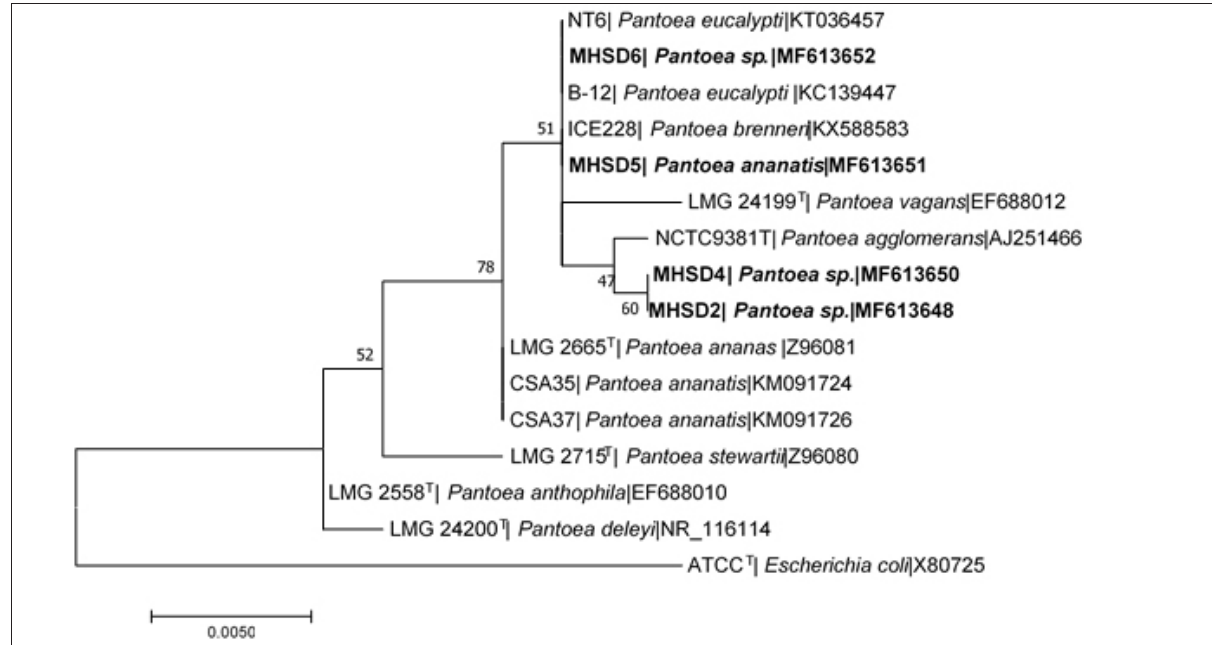
Figure 7: Maximum likelihood tree based on the 16S rRNA gene sequences of Pantoea spp. isolated in this study and their closest phylogenetic neighbours. The numbers on nodes indicate bootstrap values after 1000 replicates expressed in percentages. Escherichia coli strain ATCC X80725 was included as an outgroup. T indicates type